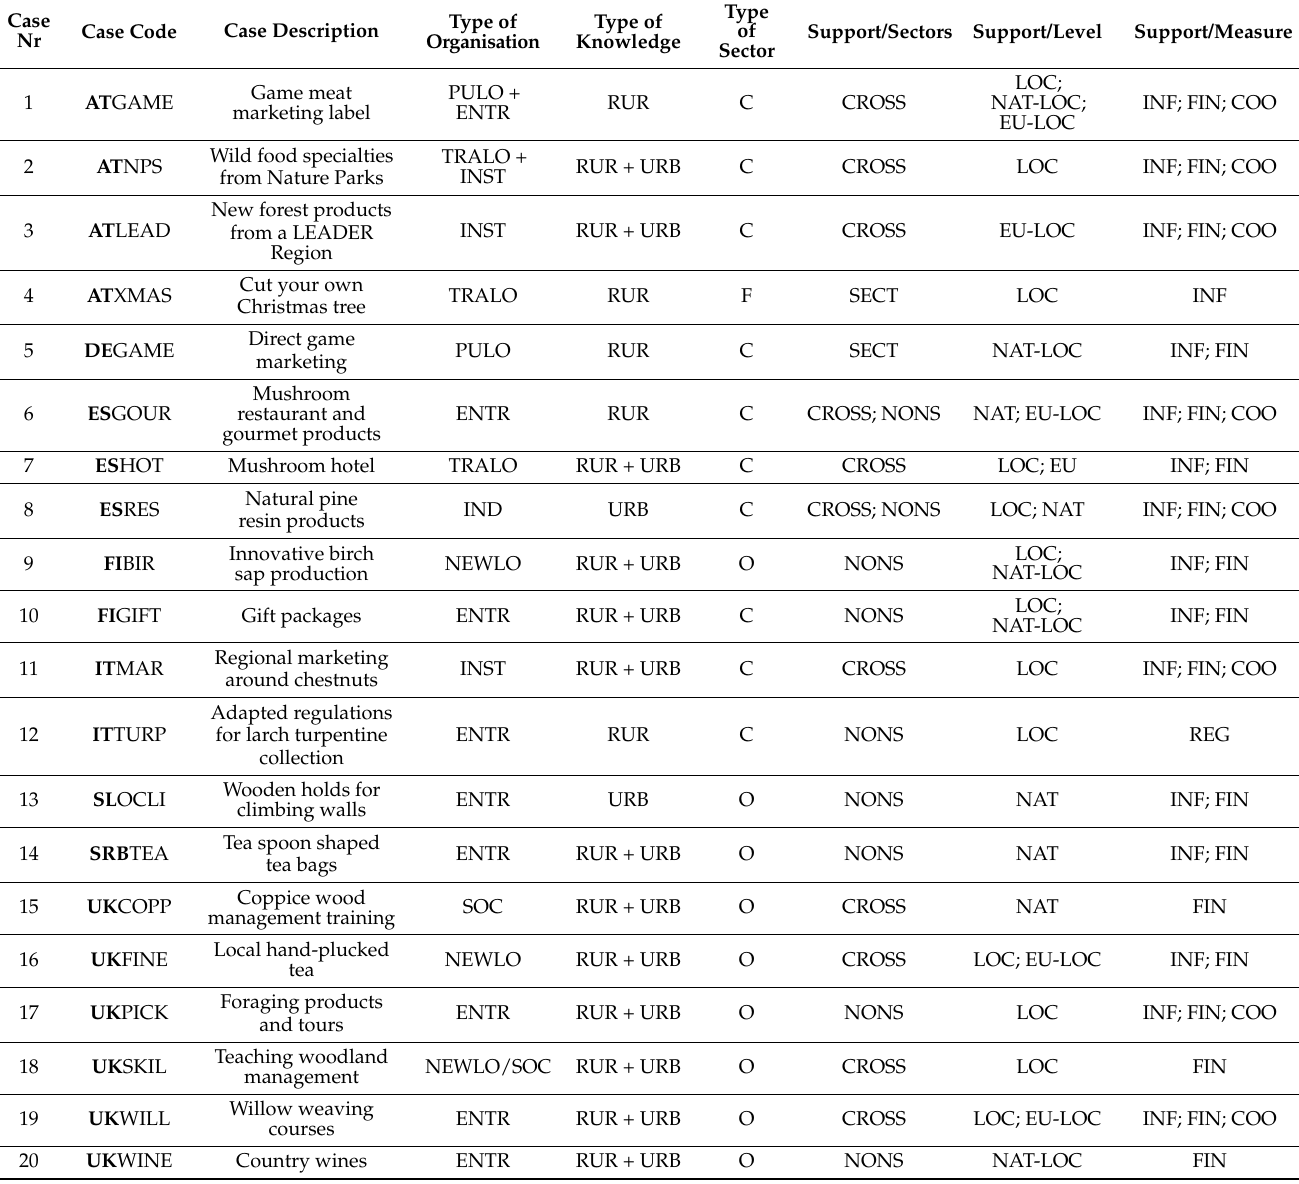
Table 1. Overview of cases and main analysis